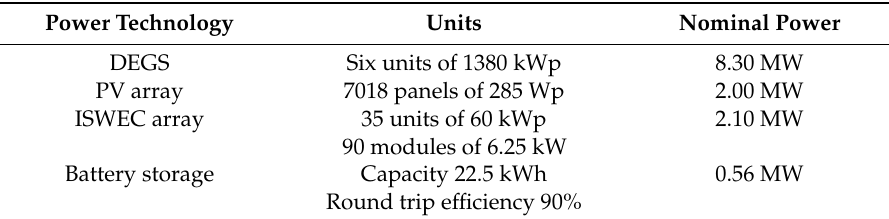
Table 3. Description of power